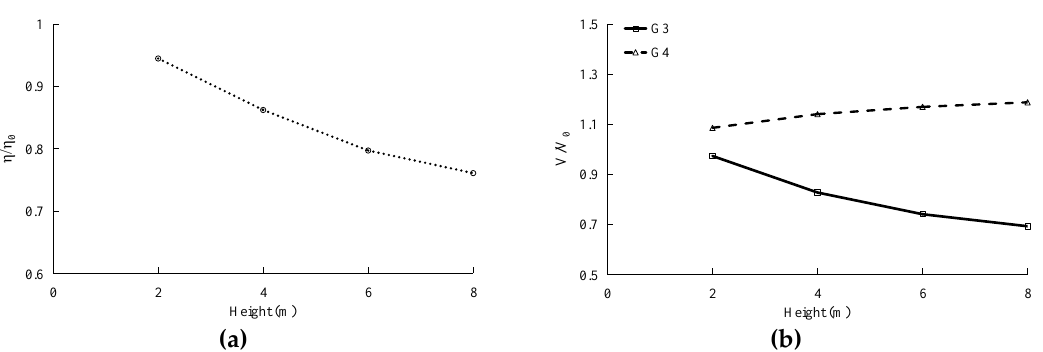
Figure 19. Variation of normalized run-up heights and normalized peak flow velocities at G3 and G4